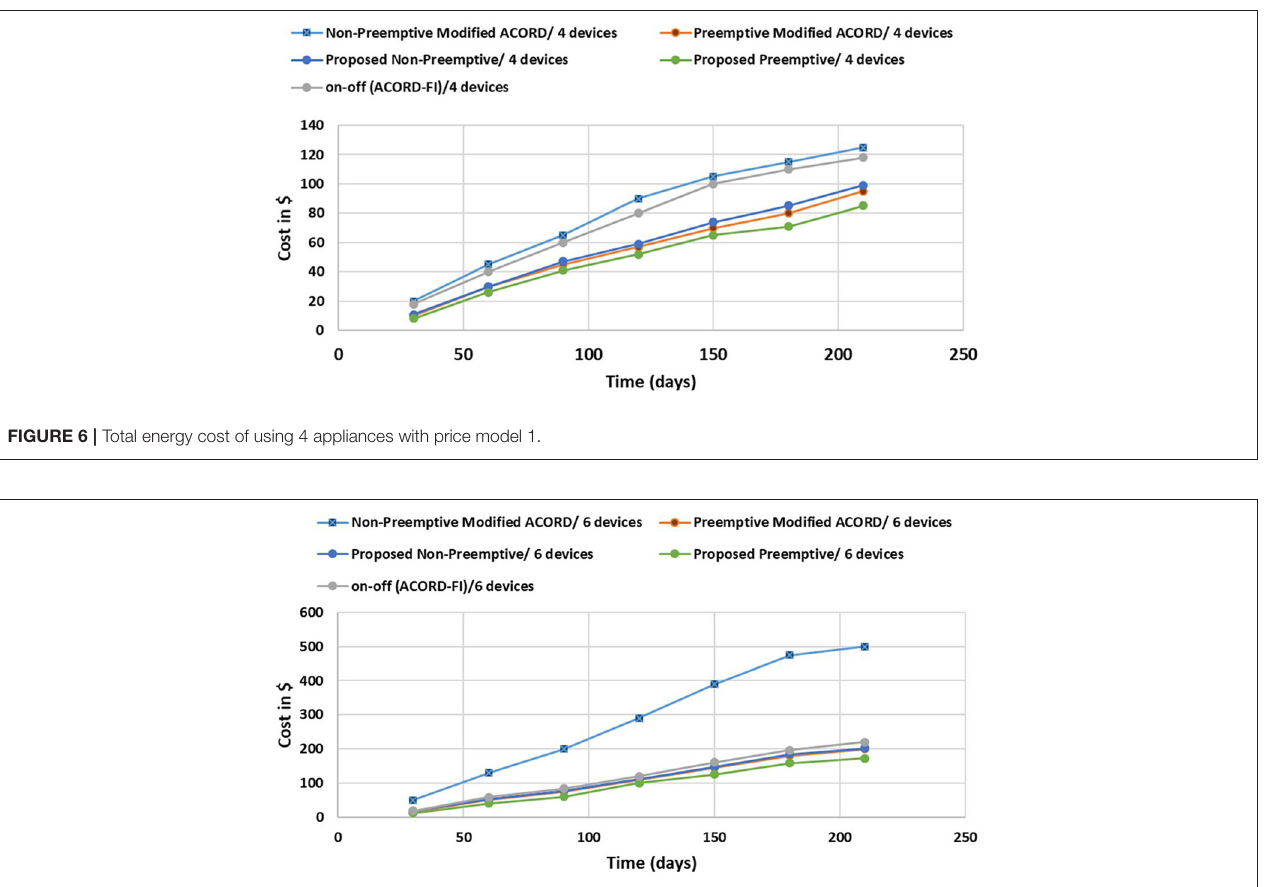
FIGURE 7 | Total energy cost of using 6 appliances with price model